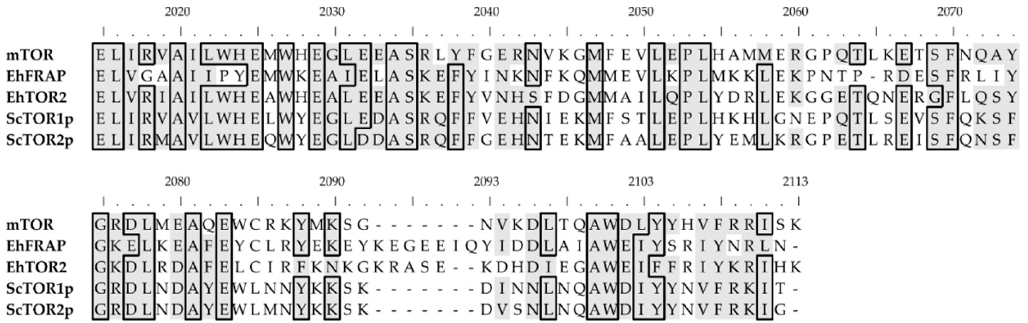
Figure 3. Multiple sequence alignment of rapamycin-binding domains. Reference sequence (range): mTOR (2015–113), Eh FRAP (2002–2105), Eh TOR2 (1841–1944), Sc TOR1p (1952–2049), and Sc TOR2p (1955–2052). Identical residues are within boxes, while those which are similar are shaded (gray). The top-ruler residue-numbering corresponds to the human mTOR sequence.